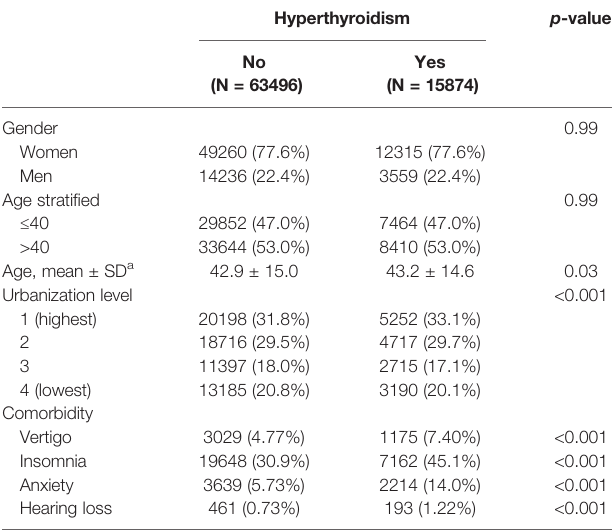
TABLE 1 | Baseline characteristics of patients with and without